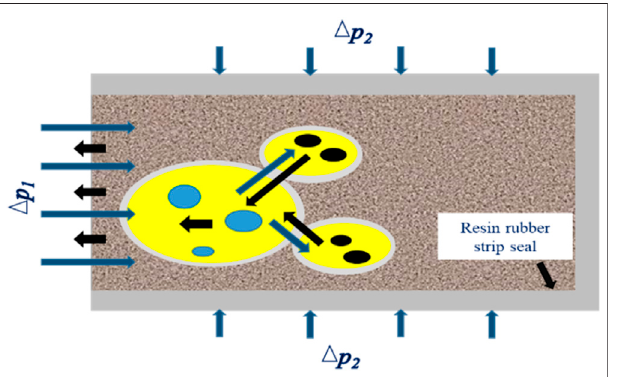
FIGURE 1 | Imbibition in a fractured stuffy well (Li et al., 2017).